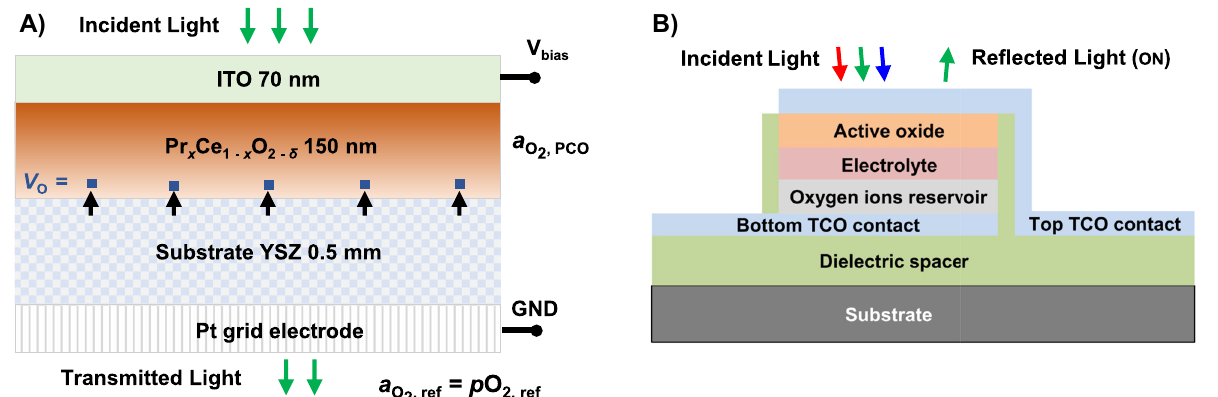
Figure 1: Electrochemical optical modulation device structures. (A) Cross section of four-layered stack of ITO/PCO/YSZ/Pt used to study the active optical tuning of PCO thin films with different compositions. Optical tuning, centered in the visible spectrum, is achieved via electrochemical titration of oxygen through the YSZ ) into and out of the actively tunable PCO layer (see text for details). (B) electrolyte (oxygen moves in YSZ and PCO via oxygen vacancies– V O Conceptual design (cross section) of proposed electrochemically controlled all-solid-state one color device (pixel) for a non-volatile reflective display. The actively tunable PCO layer enables modulation of the device reflectance via the same mechanism as explored in this study in the transmission